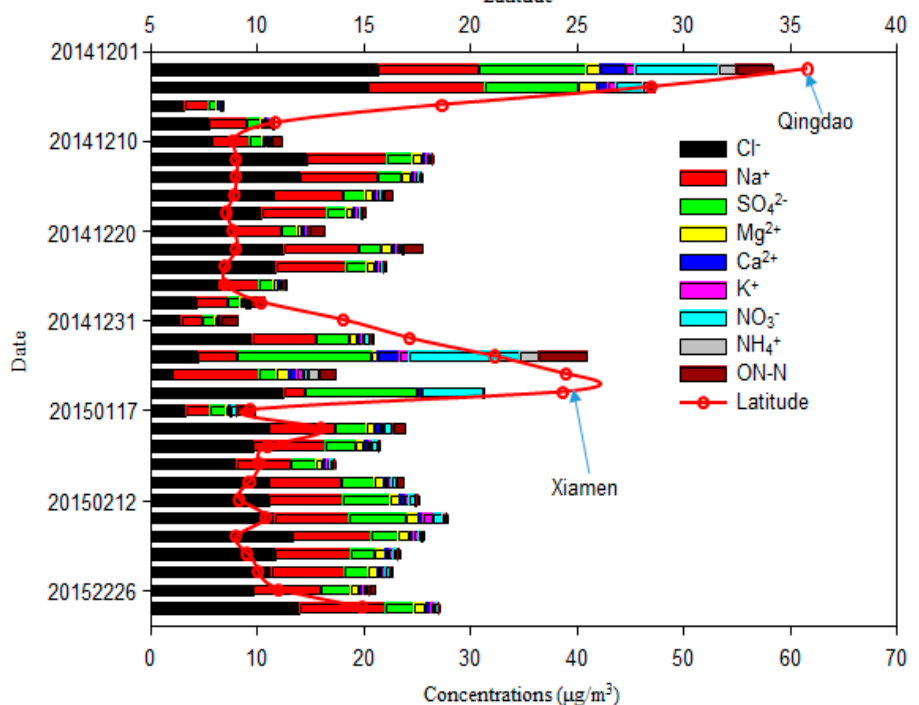
Figure 4. Concentrations of major ions in aerosols over the western North Pacific. Atmosphere 2018 , 9 , x FOR PEER REVIEW